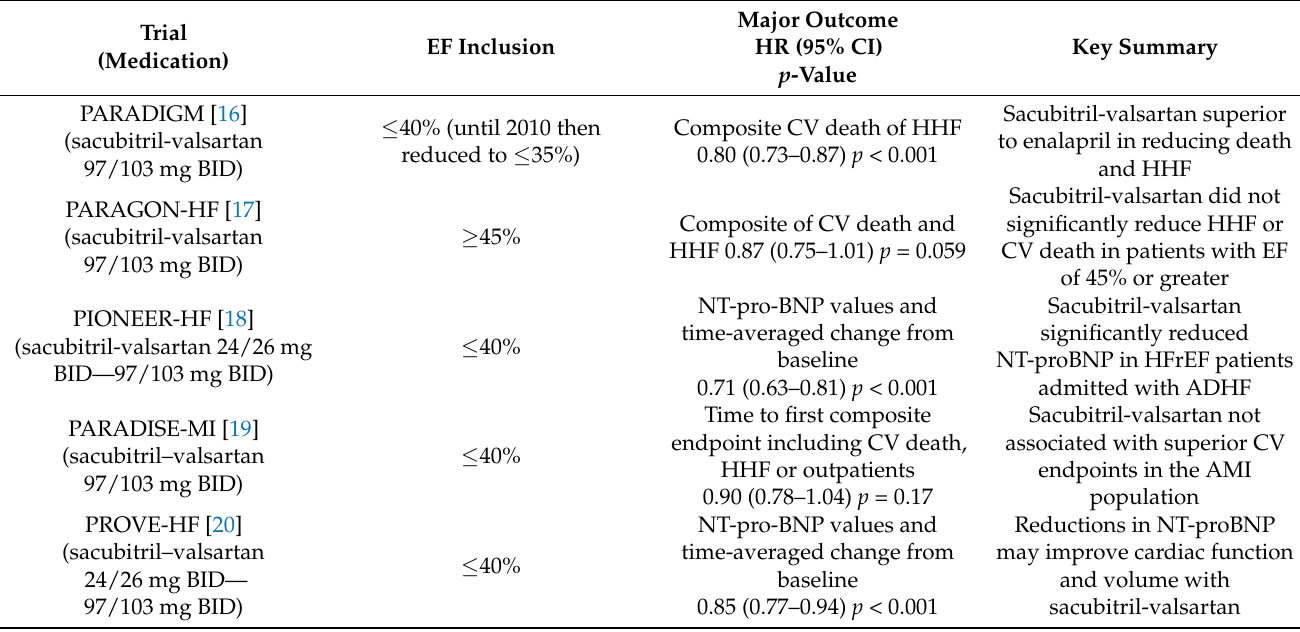
Table 3. Sacubitril–valsartan heart failure